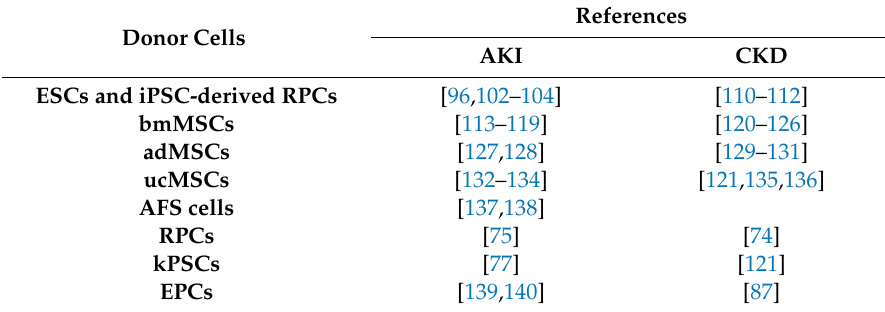
Table 2. Stem cell-based therapy in experimental kidney